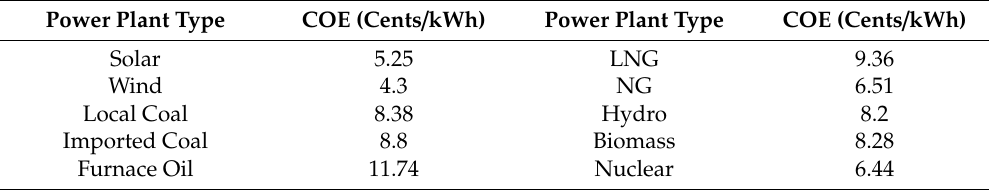
Table 1. Cost of electricity from di ff erent types of power plants in Pakistan. Power Plant Type COE (Cents /